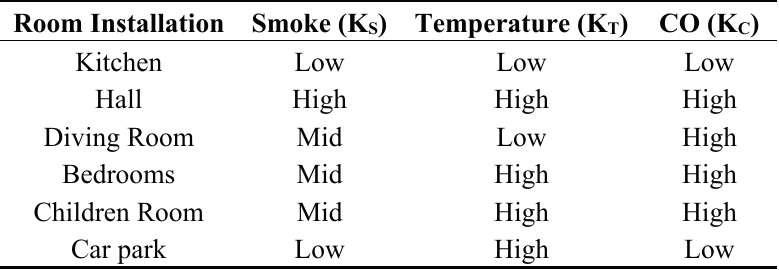
Table 1. Correction factor against